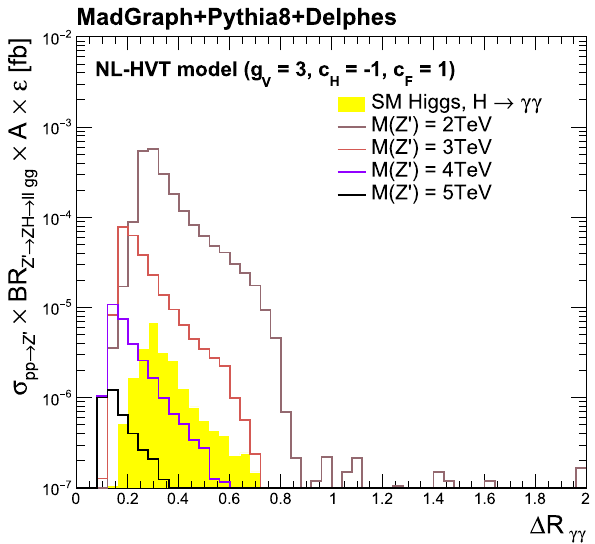
Fig. 7 Z (cid:2) → Z H → (cid:10)(cid:10)γγ Higgs yields with respect to Δ R γγ , dN / d Δ R γγ , in fb, after a diphoton transverse momentum cut of P T > 800GeV, as predicted from the non-local form factor in Eq. 3 with a = 1. The expected SM Higgs yield for the same selection is overlayed in